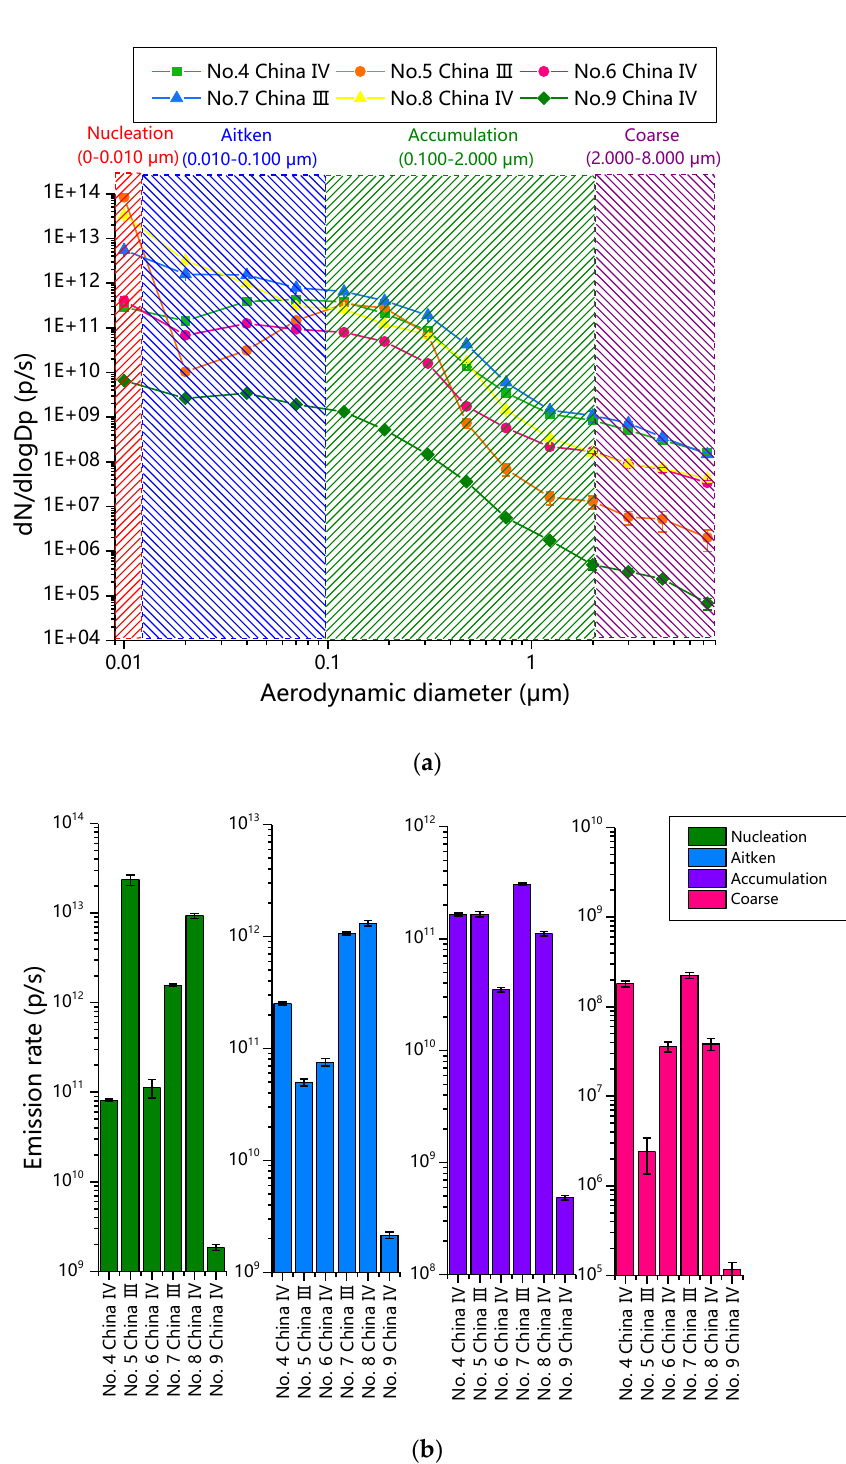
Figure 8. The PN average emission characteristics of test vehicles. ( a ) The average PN size distribution (average ± 95% confidence interval) of each particle mode; ( b ) The average emission rates (average ± 95% confidence interval) of each particle mode.